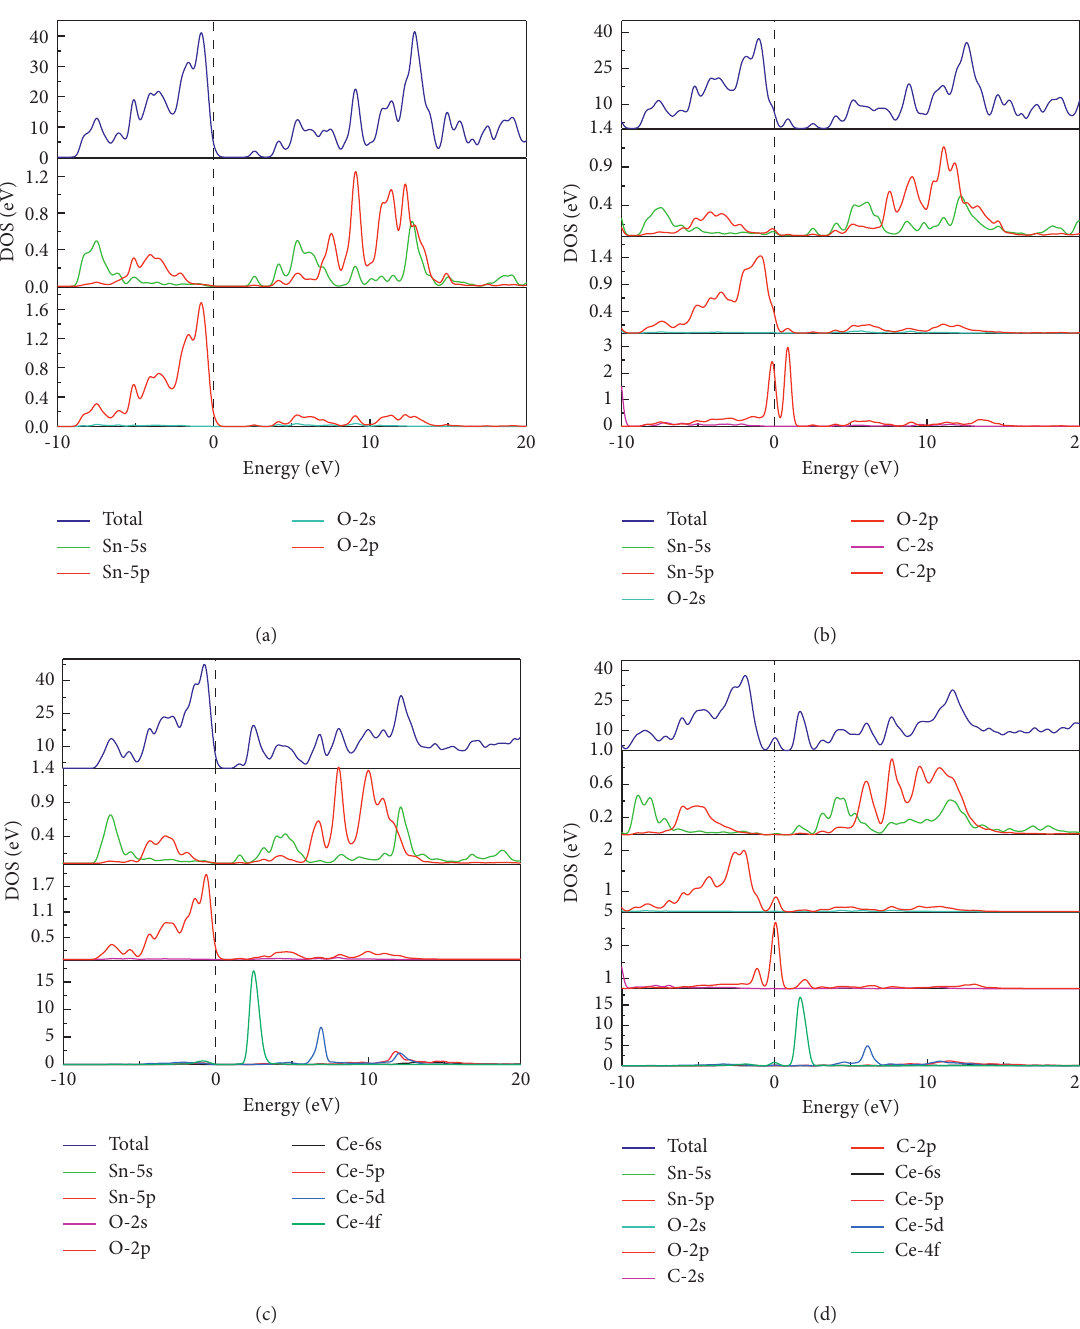
Figure 3: Densities of states: (a) pure SnO 2 , (b) C-doped, (c) Ce-doped, and (d) Ce-C